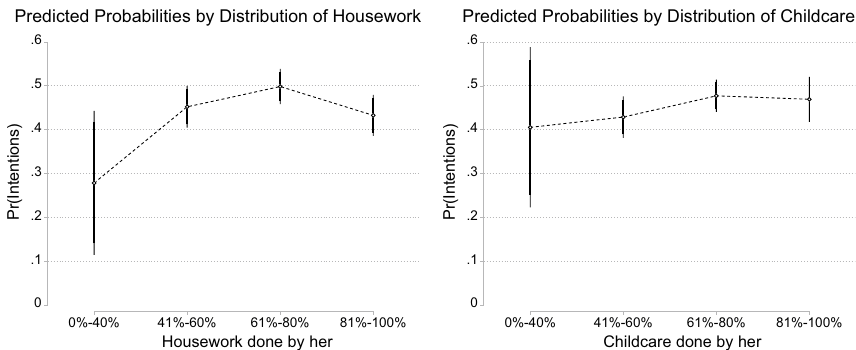
Fig. 3 Predicted probabilities of one-child mothers’ fertility intentions by housework and childcare distribution. Error bars at 90% (thin) and 95% (thick). Models control for housework/childcare duties done by other individuals, woman’s age, child’s age, migrant background, women’s attachment to the labour force, men’s labour force status, differences in partners’ educational attainment, partner’s children and